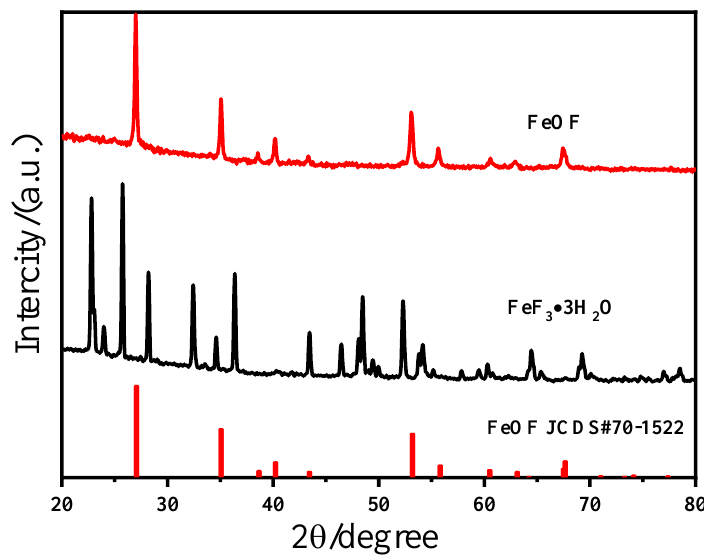
Figure 2. XRD patterns of the precursor and the synthesized sample. Table 1. Structural parameters of FeOF and FeF3·3H2O determined from XRD data. Sample